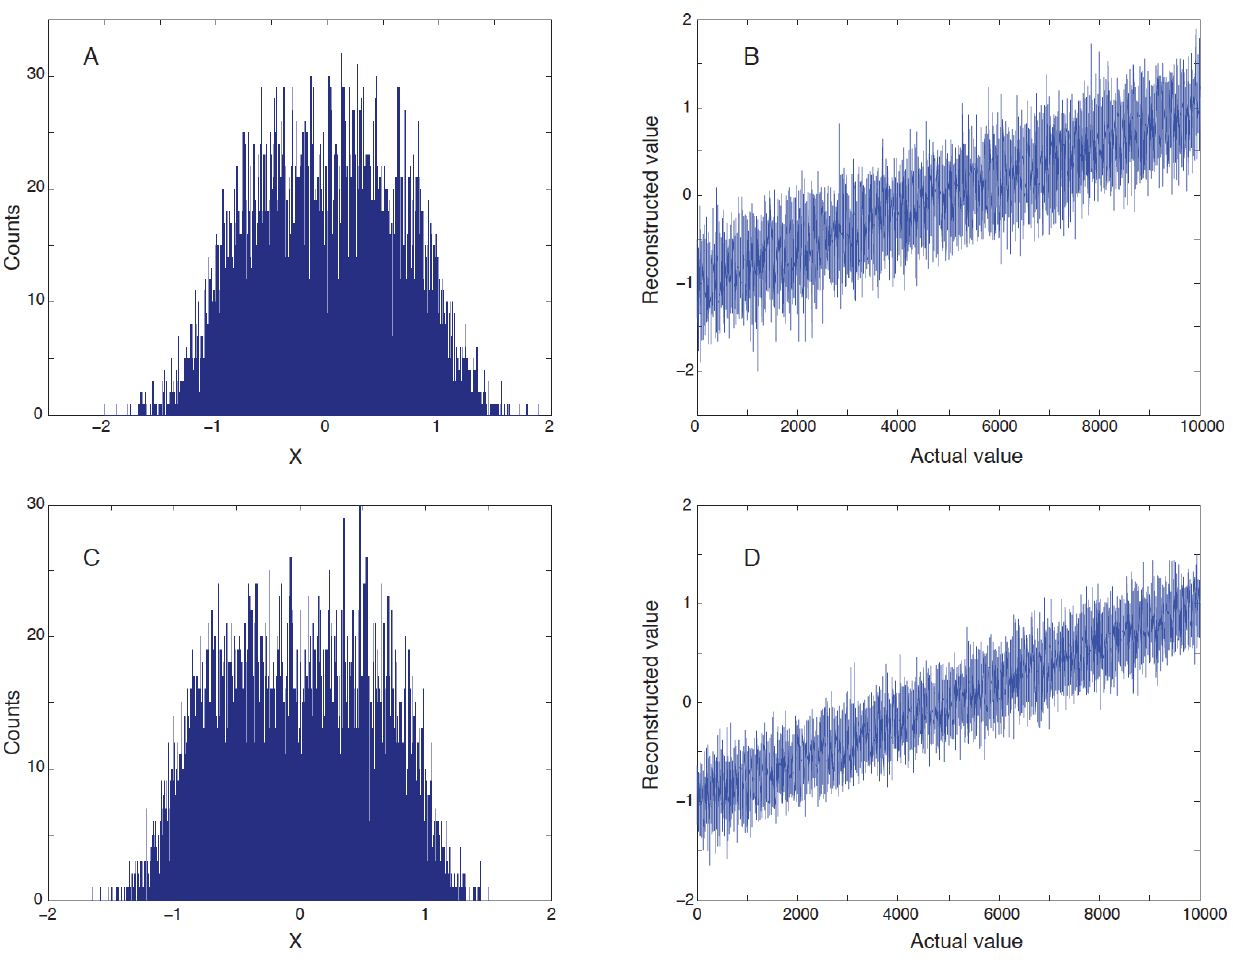
Figure 2. Validation of the method by reconstruction of the order of numbers. ( A ) Histogram. N = 10,000, 2–4 connections, 1000 bins; ( B ) Reconstructed order of numbers. N = 10,000, 2–4 connections. Results with increased numbers of connections; ( C ) Histogram. N = 10,000, 2–8 connections (10 on average), 1000 bins; ( D ) Reconstructed order of numbers. N = 10,000, 2–8 connections (10 on